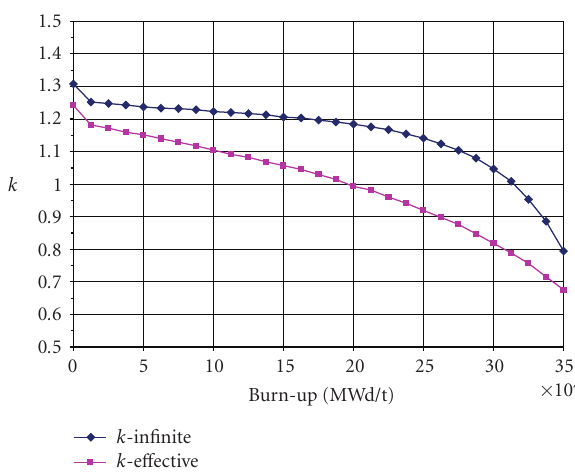
Figure 10: k -infinite and k -e ff ective trends as a function of burn-up (expressed in